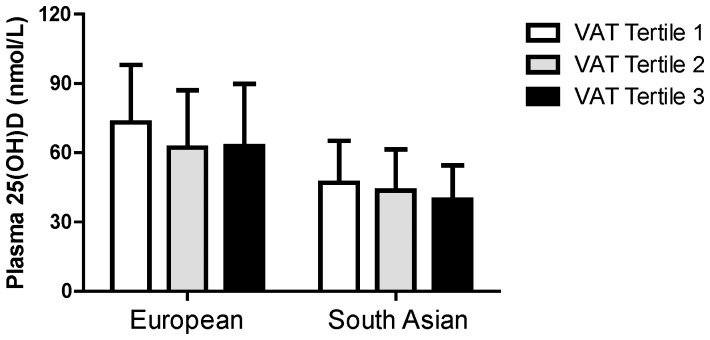
Plasma 25(OH)D concentrations by VAT tertiles in European and South Asian subjects.Plasma 25(OH)D concentrations were significantly different (p = 0.01) between VAT tertiles and significantly lower (p<0.001) in South Asians.